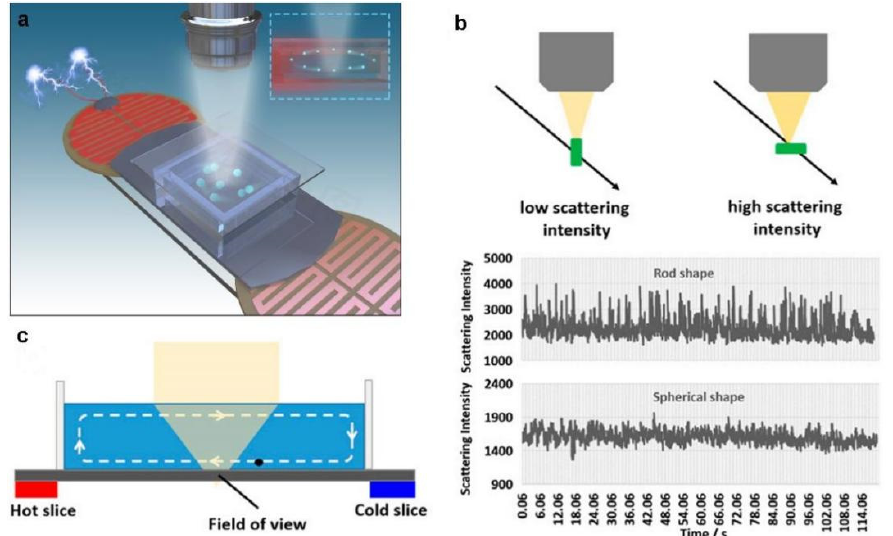
Figure 7. Bacteria detection principle by a single-particle imaging approach. ( a ) Schematic diagram of bacteria detection by single-particle imaging. ( b ) The inhomogeneity of particle morphology is identified by tracking the fluctuations of scattering intensity in free solution. ( c ) Convection induced by an electric heater was used to screen individual bacteria in a small field of view [121]. Adapted with permission from Ref. [121]. Copyright © 2022 The Author(s).